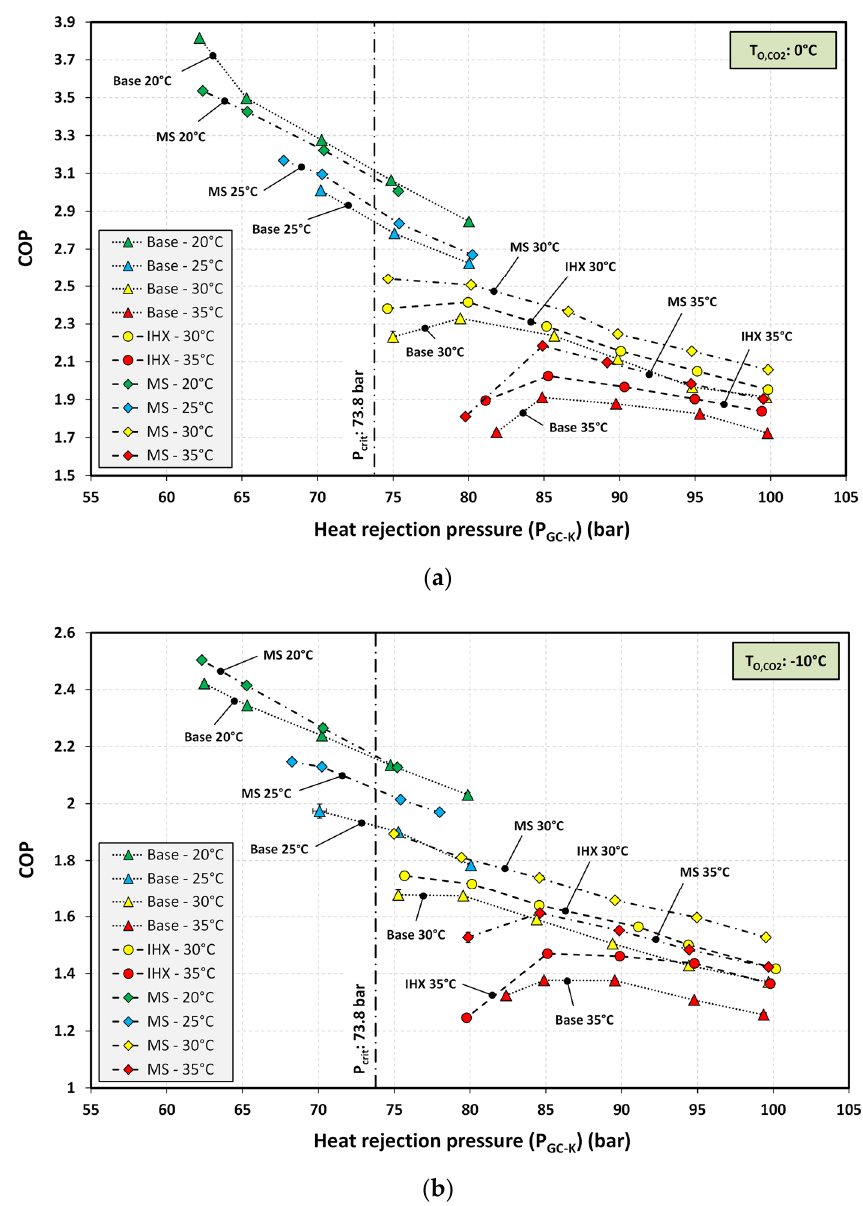
Figure 6. Average COP of the refrigerating plant at 0 ◦ C ( a ) and − 10 ◦ C ( b